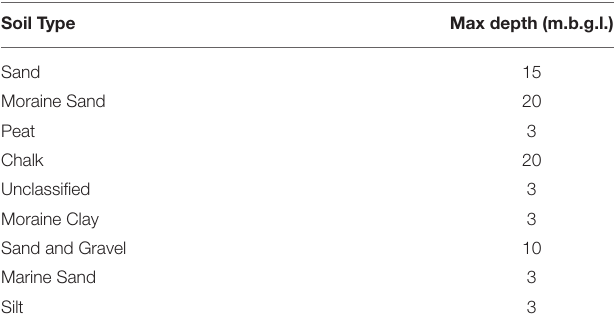
TABLE 1 | Threshold depths that define a shallow well with respect to soil types ( Figure 1 ). Soil Type